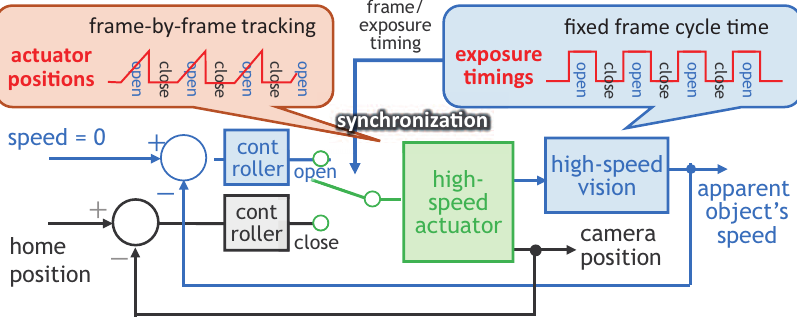
Figure 1. Control scheme in camera-driven frame-by-frame intermittent